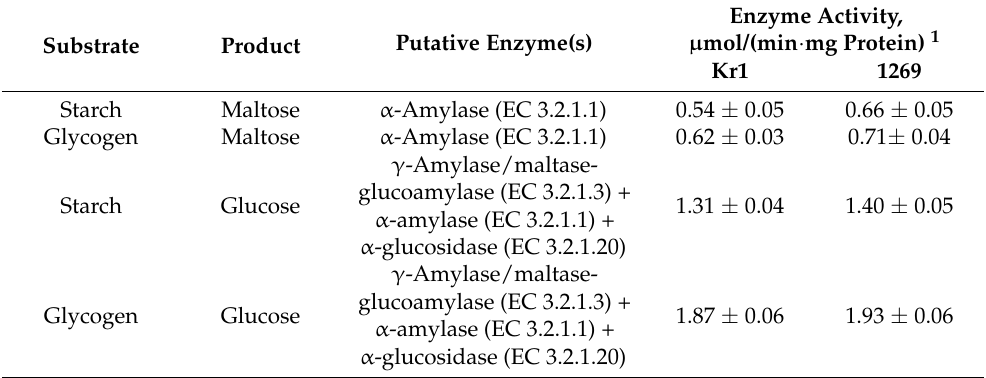
Table 2. α -Glucan (starch and glycogen) degradation by extracellular enzymes of S. thermotolerans Kr1 and S. thermosulfidooxidans